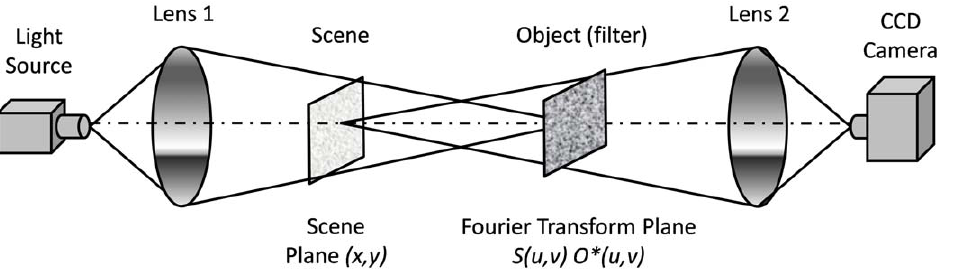
Figure 1. Convergent Vander- Lugt optical correlator. O is a monochromatic source light, L1 and L2 are lenses, the scene and the filter planes hold both images to correlate and a CCD camera registers the correlation plane. The Fourier transform of the input image s(x,y) is obtained at the Filter plane where the optical correlation S(u,v)H*(u,v) takes place. The correlation result c(x,y) is captured by the CCD camera.